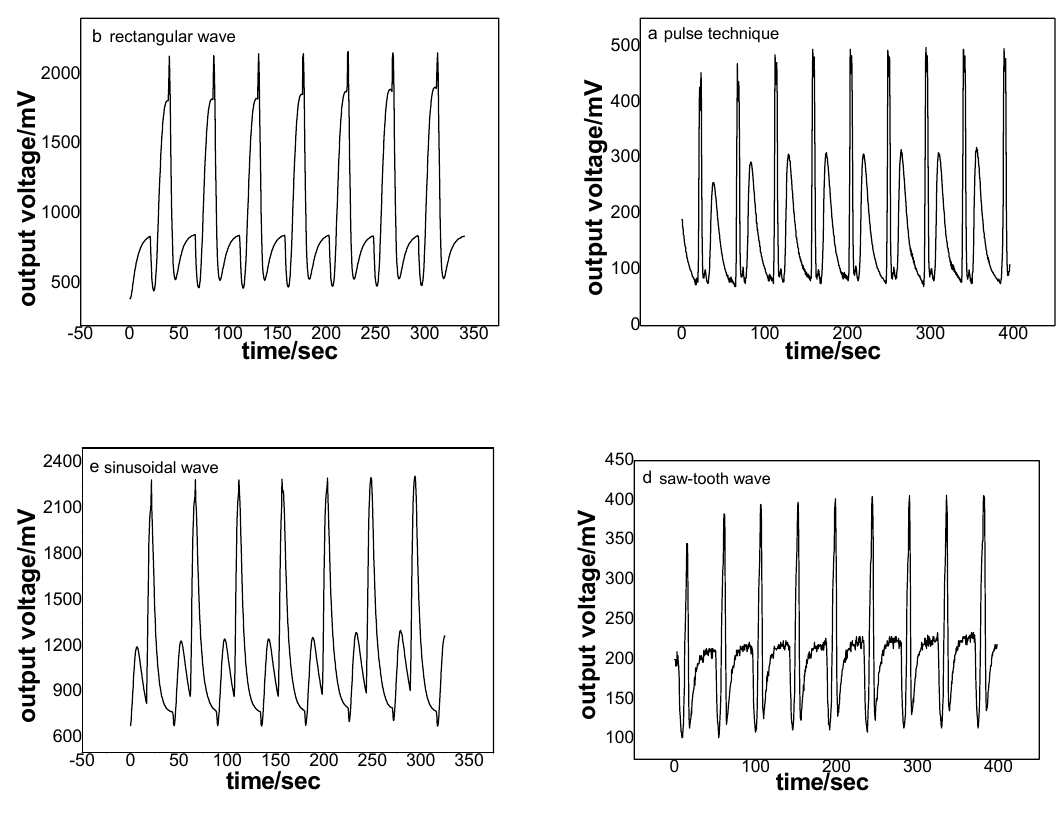
Figure 6. Effect of modulation waveform on the dynamic response of methanol. Experimental conditions: applied potential 7 V, modulation frequency 20